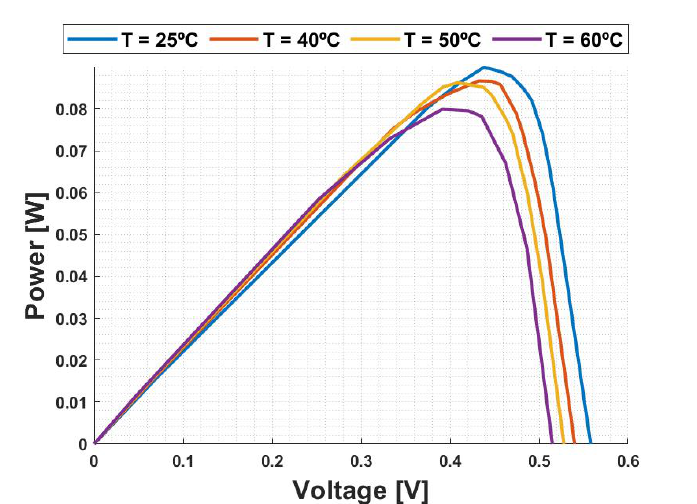
Figure 15. Summary of the P-V curves obtained with the d1MxP model for different